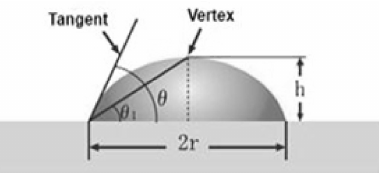
Figure 3. Scheme for the measurement of the average contact angle: h is the height and r is half the width of the